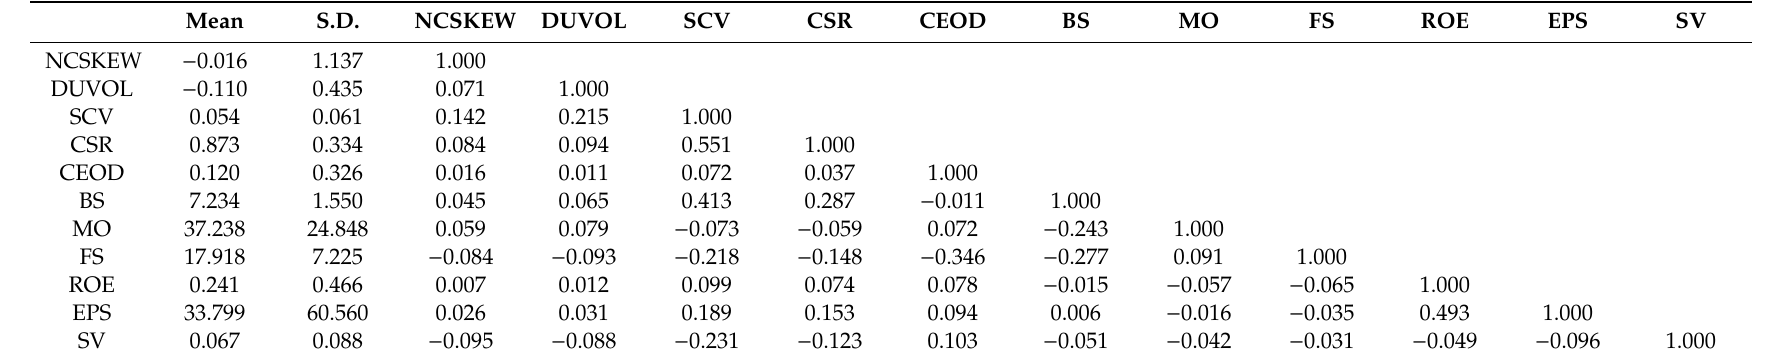
Table 2. Descriptive statistics and correlation analysis